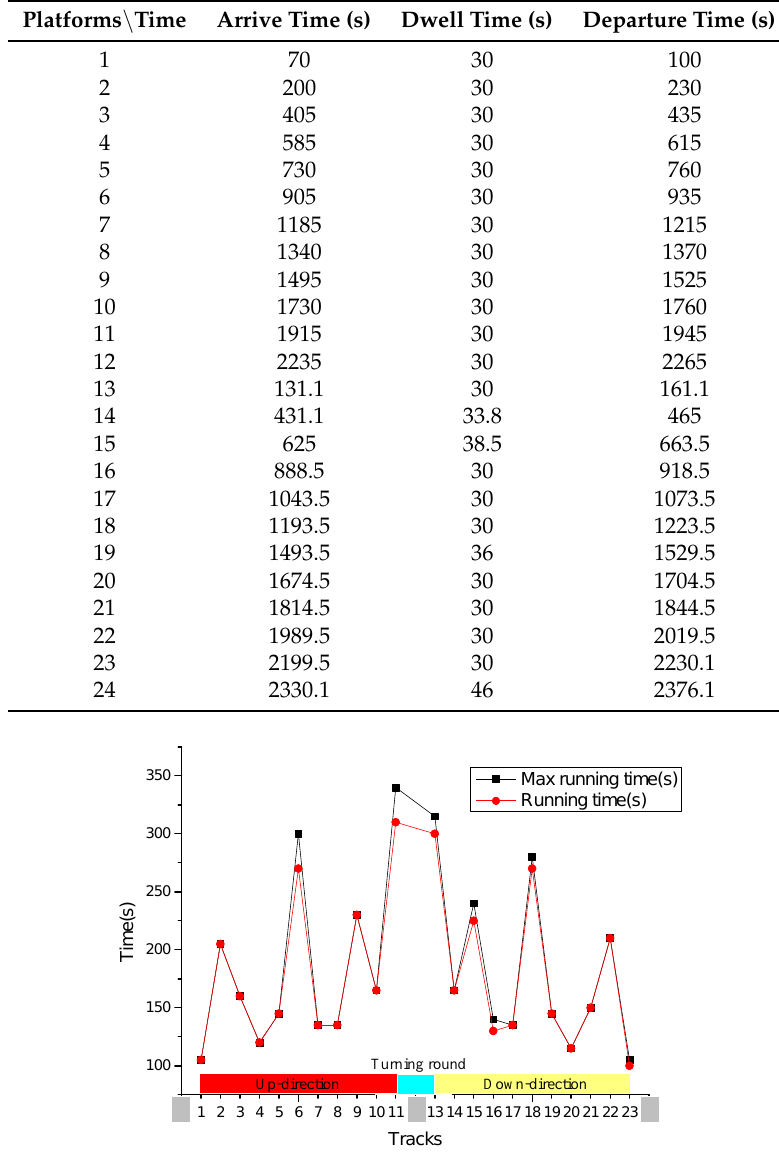
Figure 10. Running time of each track under an energy consumption